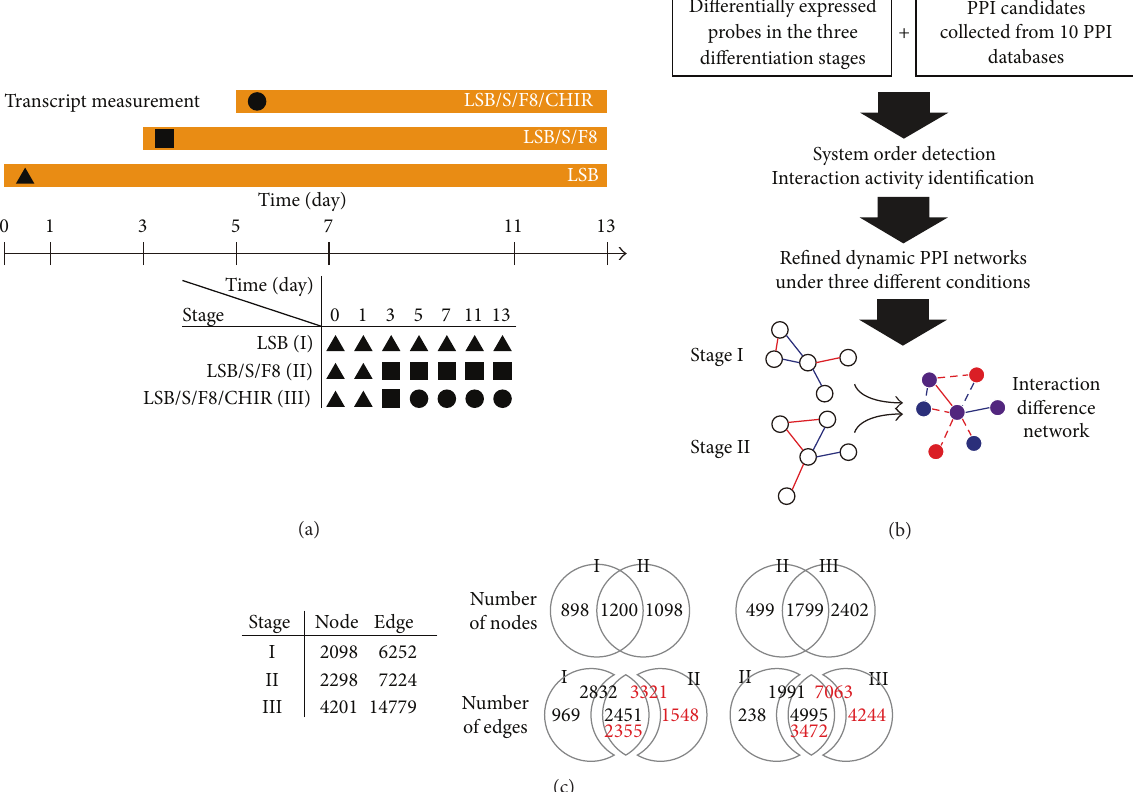
Figure 1: Overview of data, flowchart, and summary of the dynamic PPI networks in the differentiation process from hESCs to DA neurons. (a) The upper part of the timeline shows three experimental conditions (LSB: 󳵳 , LSB/S/F8: ◼ , and LSB/S/F8/CHIR: e ) used in [5]. The numbers on the timeline indicates the sampling time points of microarray data (days 0, 1, 3, 5, 7, 11, and 13). The lower part of the timeline showsthethreedifferentiationstagescomprisingofthedatafromthethreeexperimentalconditions.(b)Abriefflowchartofdynamicnetwork construction. Using PPI candidates from databases, the data of the three differentiation stages, and dynamic network modeling, three PPI networks corresponding to three differentiation stages are constructed. Then the interaction difference network (IDN) can be derived from the two networks of differentiation stages. (c) In the table at left, it shows the total number of nodes and edges at three stages. The Venn diagram at top-right shows the distribution of number of nodes between stage I and stage II and between stage II and stage III. The Venn diagram at lower right shows the distribution of number of edges between stage I (black) and stage II (red) and between stage II (black) and stage III